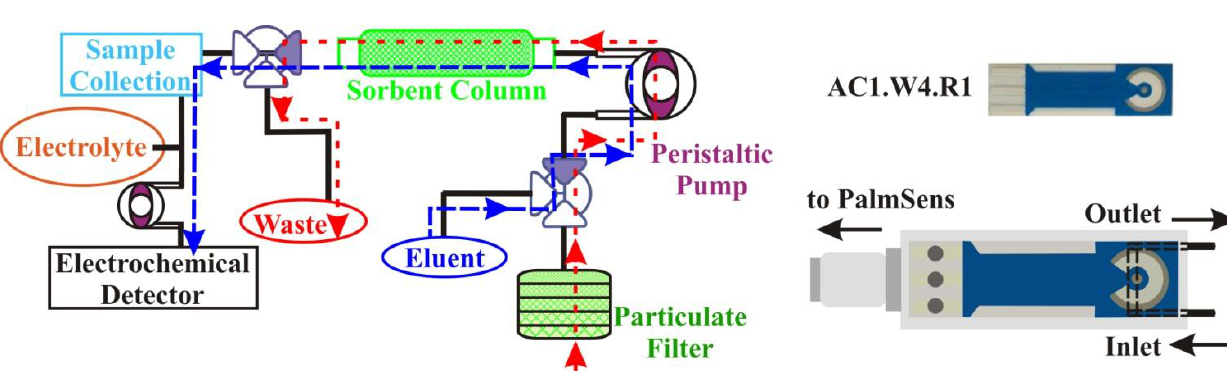
Figure 1. System Components. In this schematic of the prototype system, the red line indicates the flow of the sample solution through the system, and the blue line indicates the flow of eluent through the system [21]. Also shown are the EC sensor employed (AC1.W4.R1) and a schematic of the flow